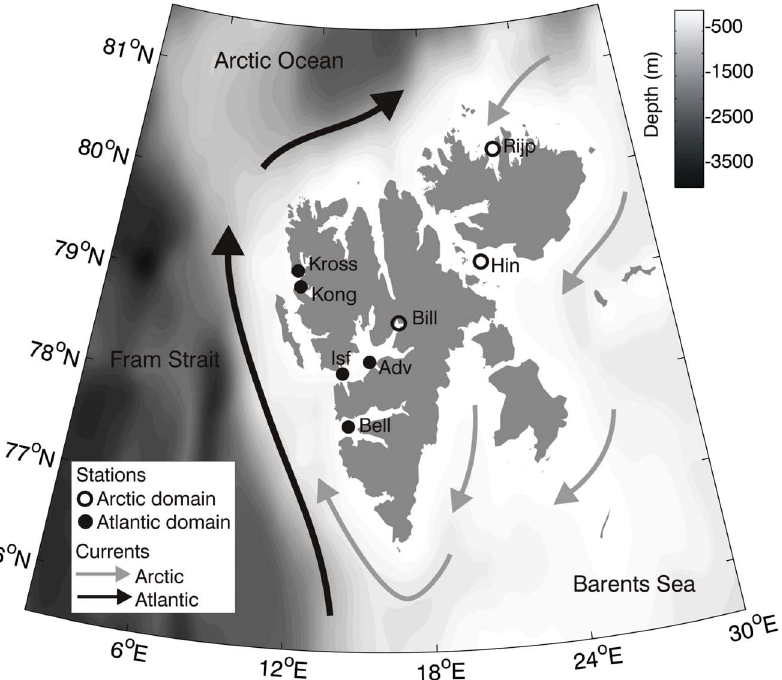
Figure 1. Sampling stations of Arctic and Atlantic domains. Map of the sampling stations with dominant current systems (Bell: Bellsund, Isf: Isfjorden, Adv: Adventfjorden, Bill: Billefjorden, Kong: Kongsfjorden, Kross: Krossfjorden, Hin: Hinlopen, Rijp: Rijpfjorden).